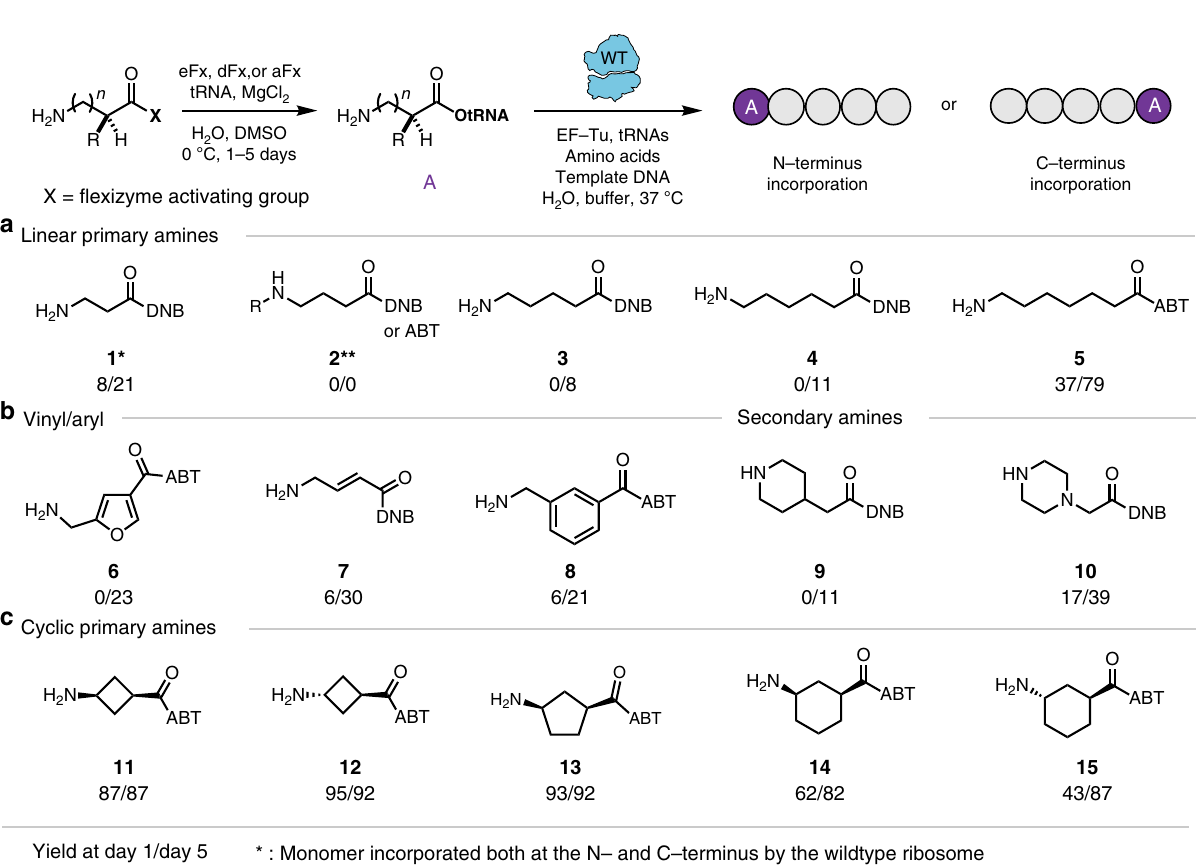
Fig. 2 Systematic design of long chain carbon and cyclic amino acids. a The range of amino acids bearing a linear carbon chain was extended to γ -, δ -, ε -, and ζ -amino acids. Higher acylation yields by Fx were observed as the amino acid chain length increased, presumably because larger (>5-membered) ring formation via lactamization is kinetically less favorable than 5-membered ring formation. b Introducing cyclic and rigid bonds into substrates helps increase Fx acylation yields. c An increased acylation yield (from ~6% for 7 up to ~95% for 12 ) was obtained for the γ -amino acids with a rigid bond ( 7 ) or cyclic structure ( 11 – 15 ). These data suggest the rigid carbon scaffold ef fi ciently inhibits the intramolecular 5-membered lactam formation reaction. The acylation yield of each substrate represents the percent yield of a microhelix tRNA observed at 24 h/120h (see Supplementary Information for gels). Data are representative of three independent